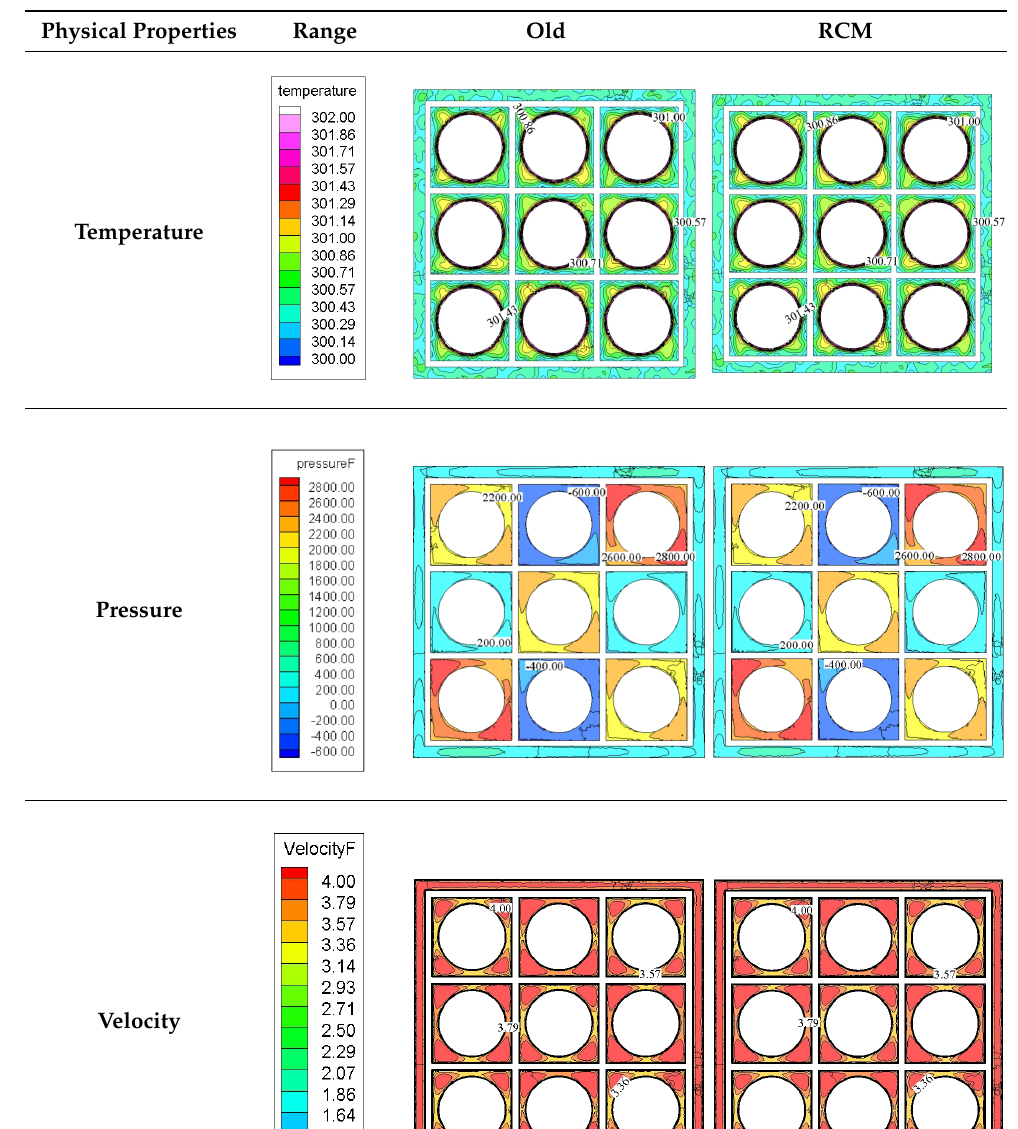
Table 4. Contour clouds for slices with Z = − 0.01. The specific information is the same as the legend in Table 3.